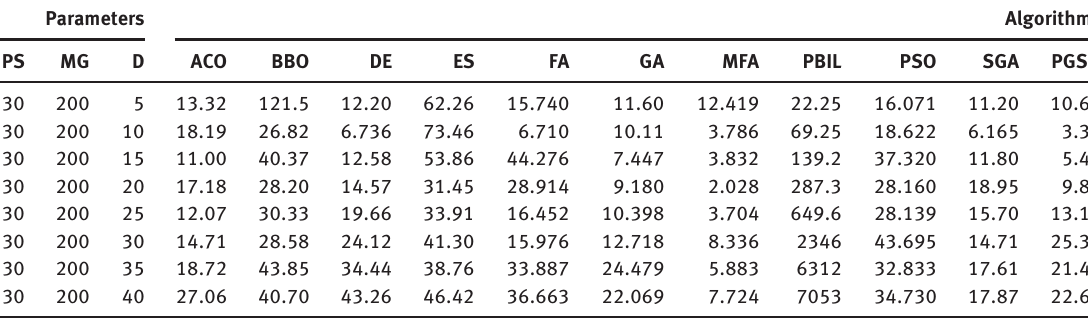
Table 9. Worst Optimization Results on Different Dimensions.